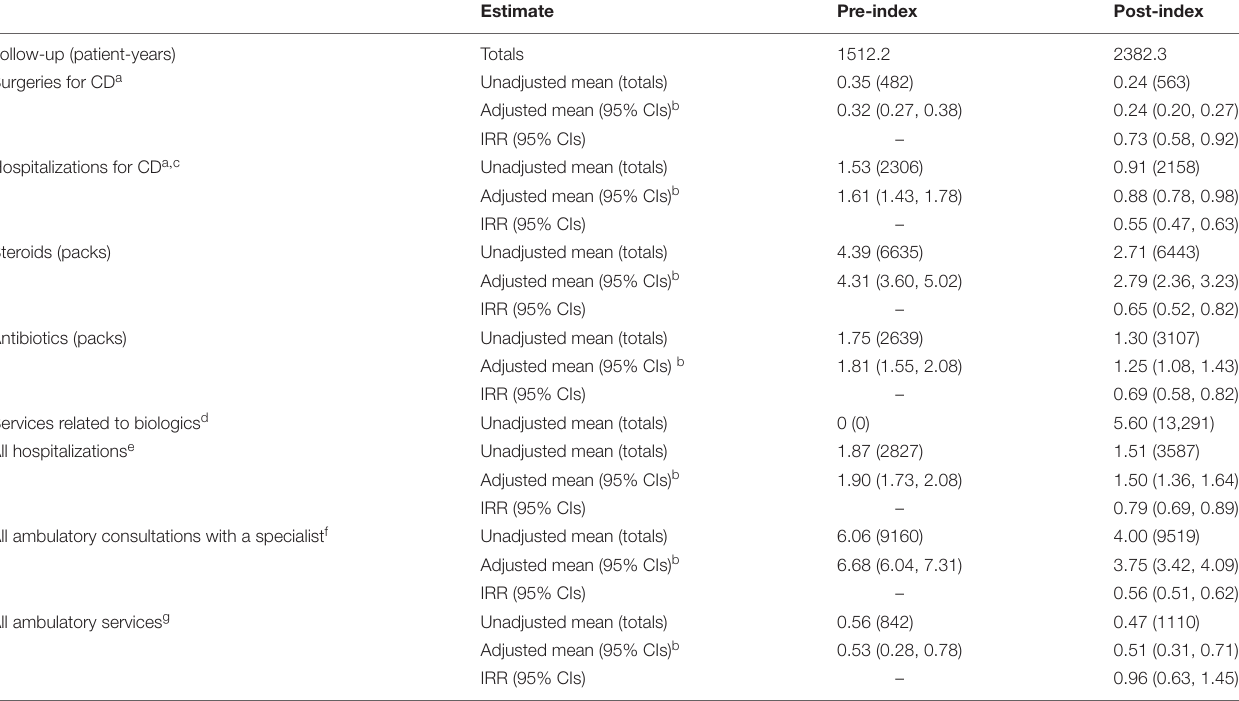
TABLE 2 | The annualized rates of medical services and medication intake before and after the first administration of biologics (pre- and post-index, respectively).